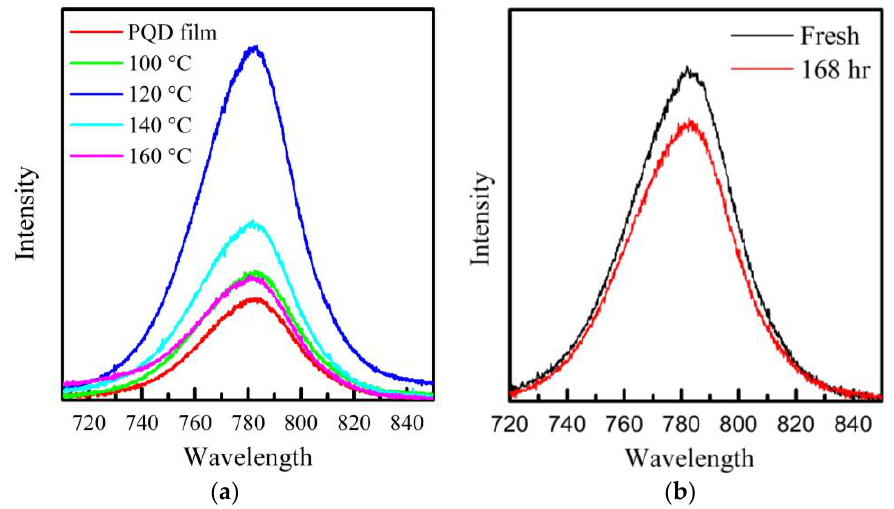
Figure 8. ( a ) PL measurement for pristine PQD at different annealing temperatures. ( b ) PL measurement for pristine PQD with annealing temperature of 120 °C (solid square) stored in ambient air for 168 h (solid circle).